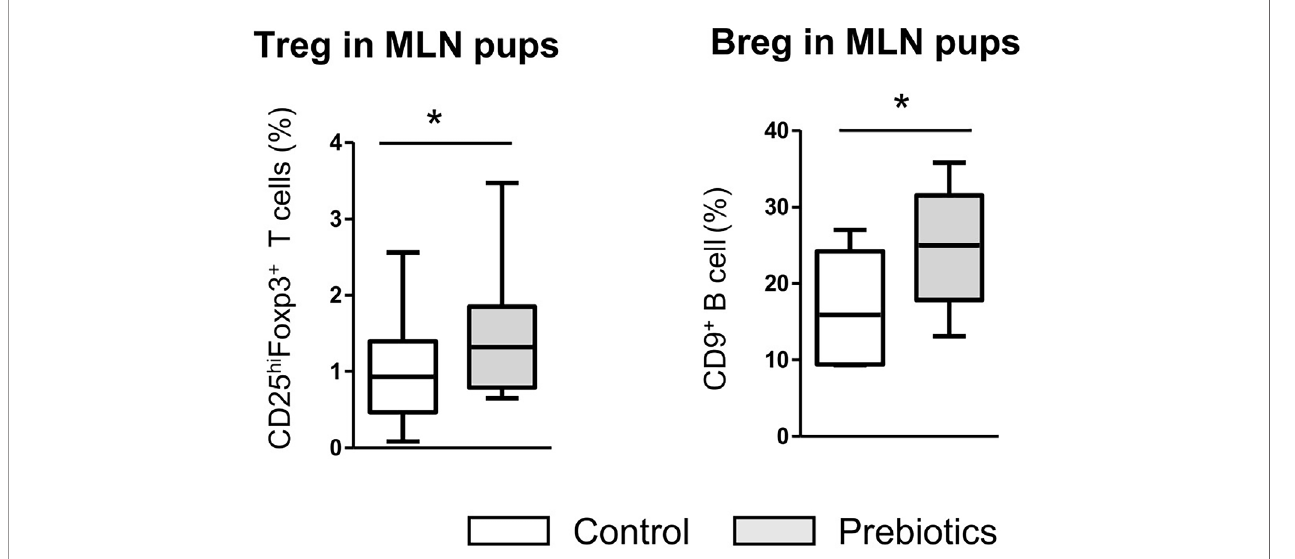
FIGURE 8 | Assessment of Breg and Treg frequencies in the mesenteric lymph nodes of pups at 7 weeks of age. Flow cytometry assessment of CD25 high FoxP3 + Treg cell and CD9 + Breg cell frequencies in the mesenteric lymph nodes of pups (7 weeks of age) after GOS/inulin prebiotic exposure during gestation (gray) or the control diet (white) (n=10, * = p<0.05).